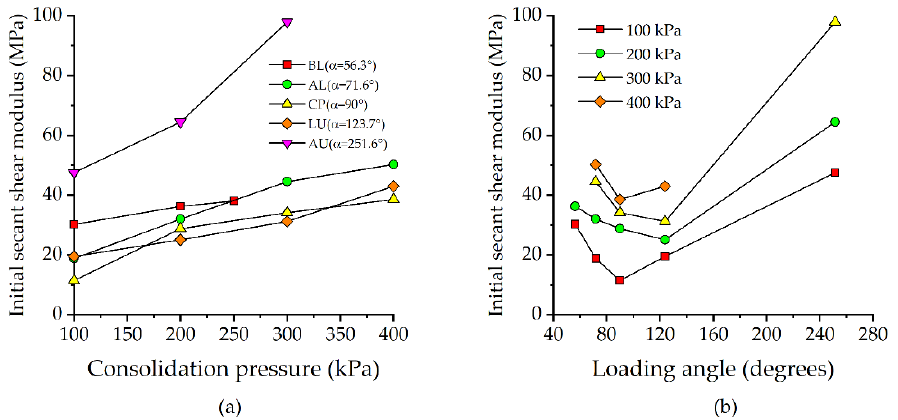
Figure 10. Variations of initial secant shear modulus with: ( a ) consolidation pressure; and ( b ) loading angle.